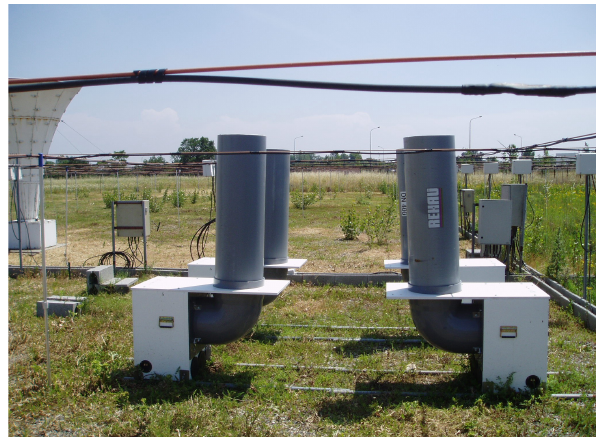
Fig. 2b. Same as Fig. 2a by replacing the iron elbow by a PVC one and 1-m extension allowing 6dB attenuation at the ground